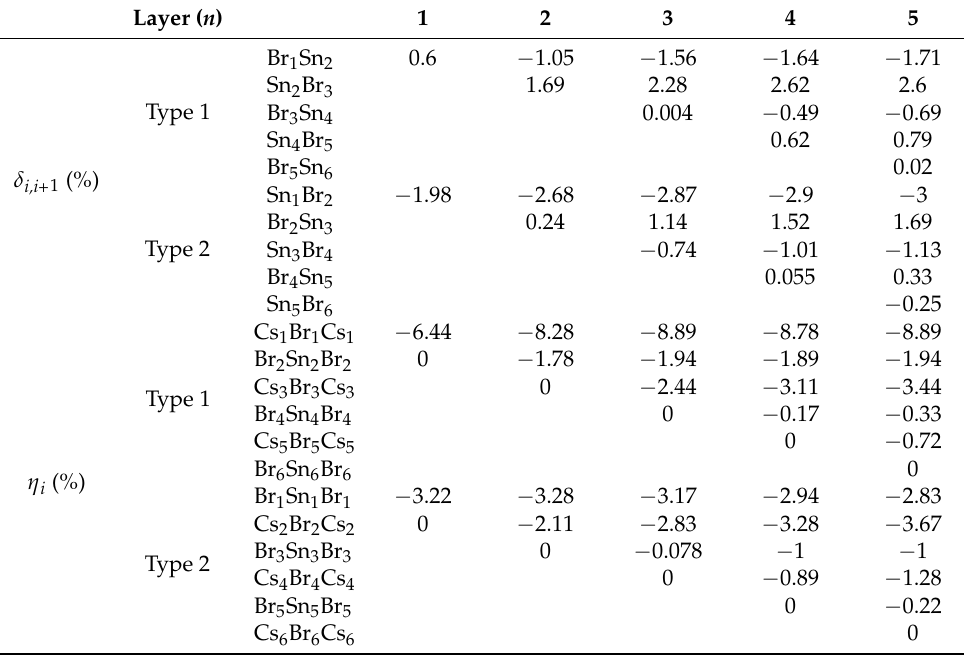
Table 1. Calculated relative displacements, δ i,i +1 (%, in unit of the calculated bulk CsSnBr 3 lattice constant), and layers rumpling, η i (%), for Cs n+ 1 Sn n Br 3 n+ 1 and Cs n Sn n+ 1 Br 3 n+ 2 ( n = 1–5). Layer ( n